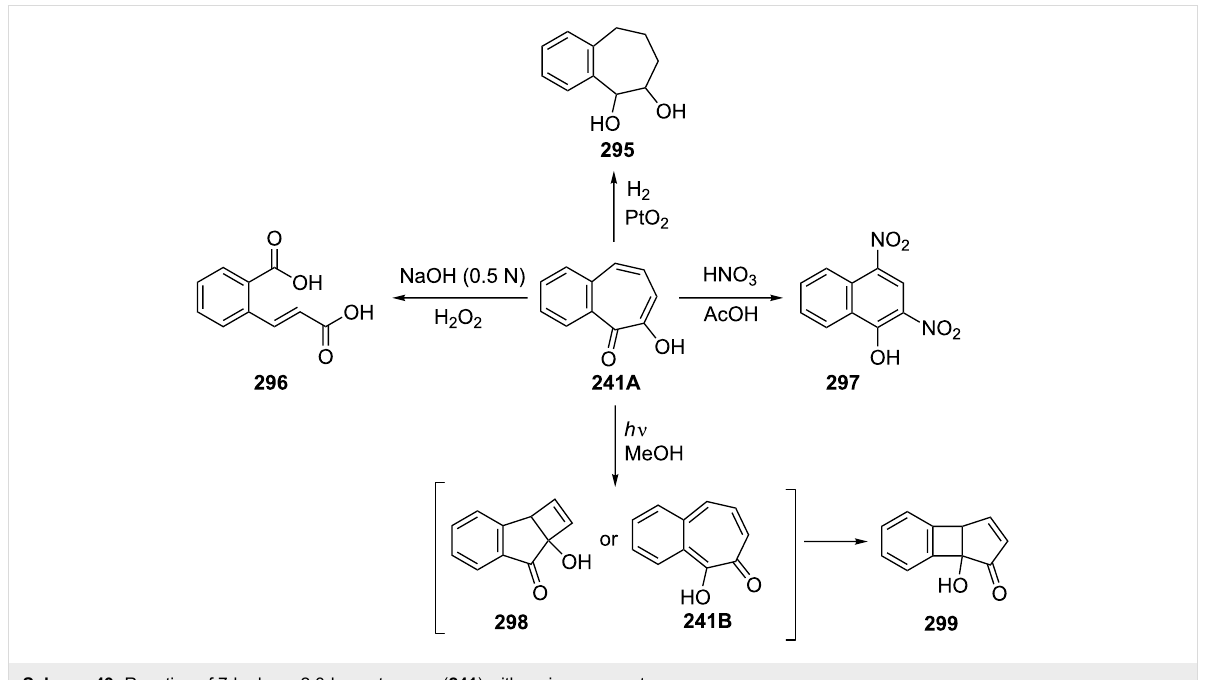
with nitric acid in an acetic acid solution afforded 2,4-dinitro-1- naphthol ( 297 ) [175] (Scheme 49). Yoshioka’s group